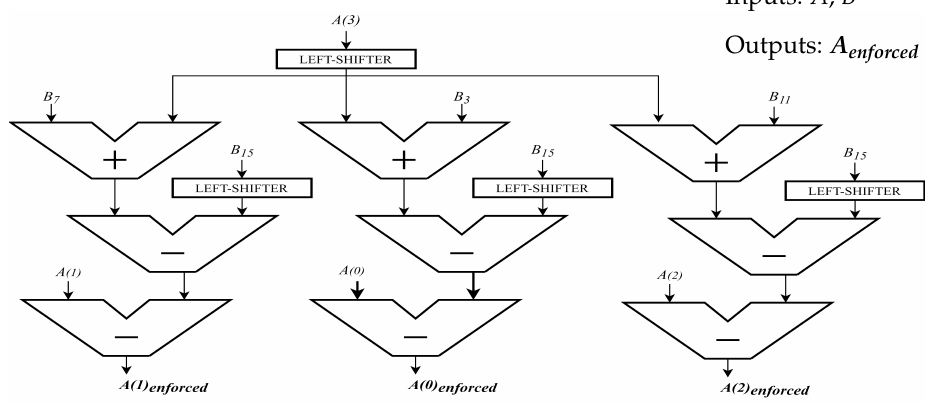
Figure 2. Enforcement